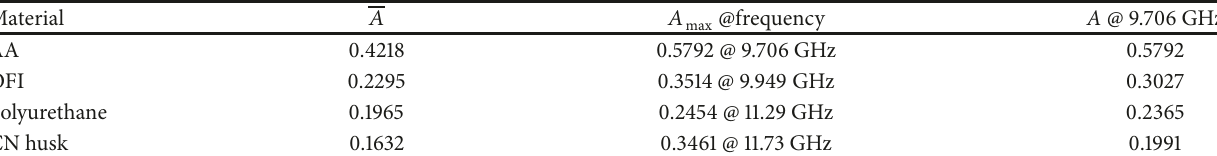
Table 1: Comparison of average absorption coefficient A for the 3 organic materials and polyurethane from 8,005 to 13 GHz.